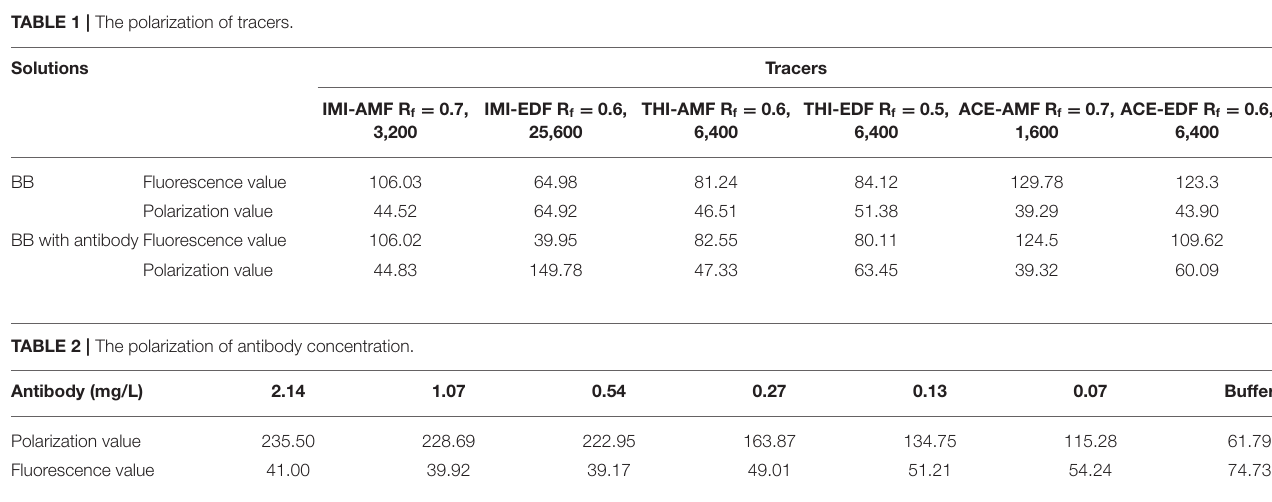
TABLE 1 | The polarization of tracers.